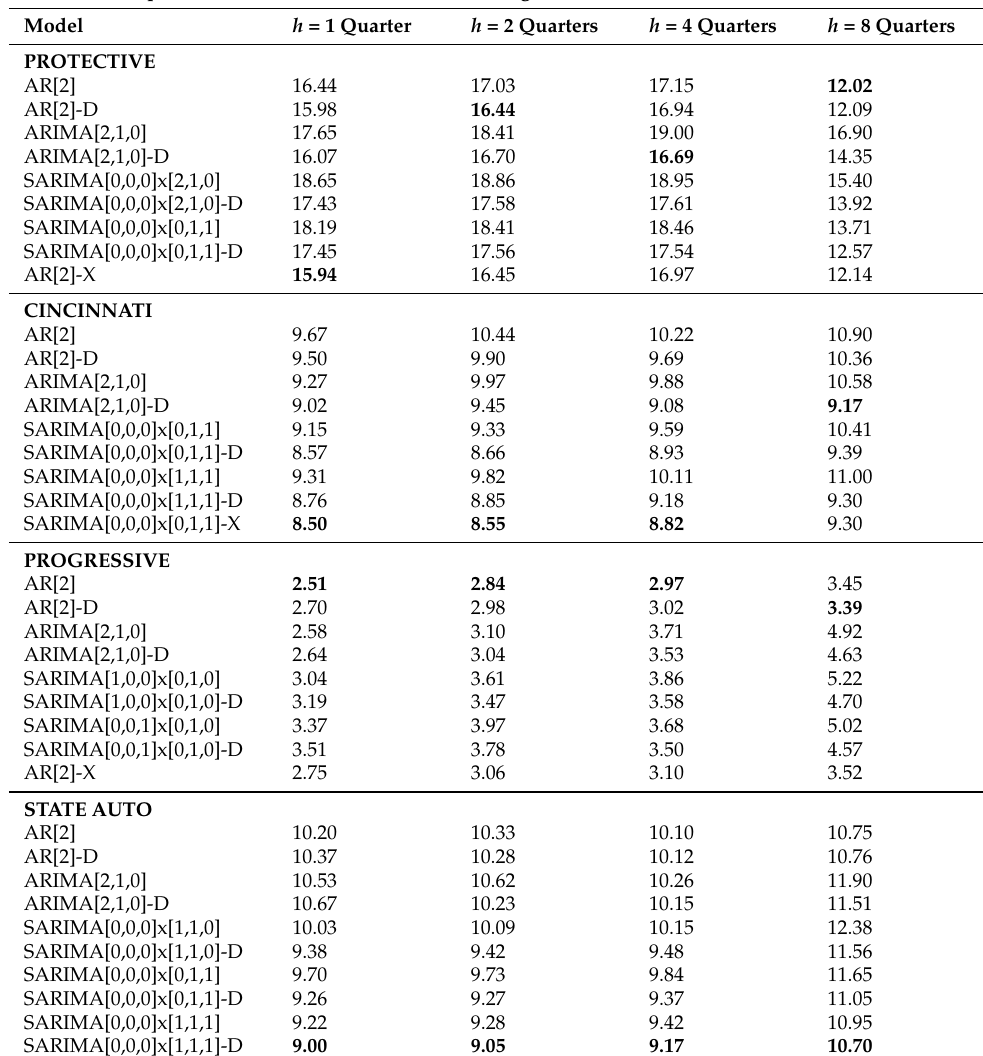
Table 3. Root mean squared errors of forecasts of underwriting ratios for the companies, Protective, Cincinnati, Progressive, and State Auto, forecast horizons h = 1,2,4 and 8 quarters. Best forecasts in bold